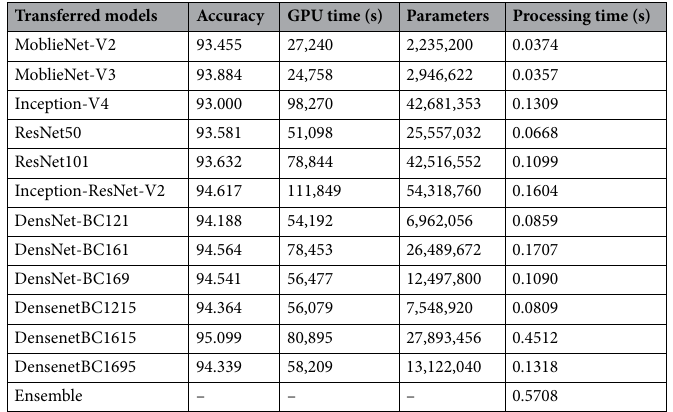
Table 3. Performance table of training models. GPU time is the processing power needed for training and validation the model. Processing time means the time of each model to identify the same input